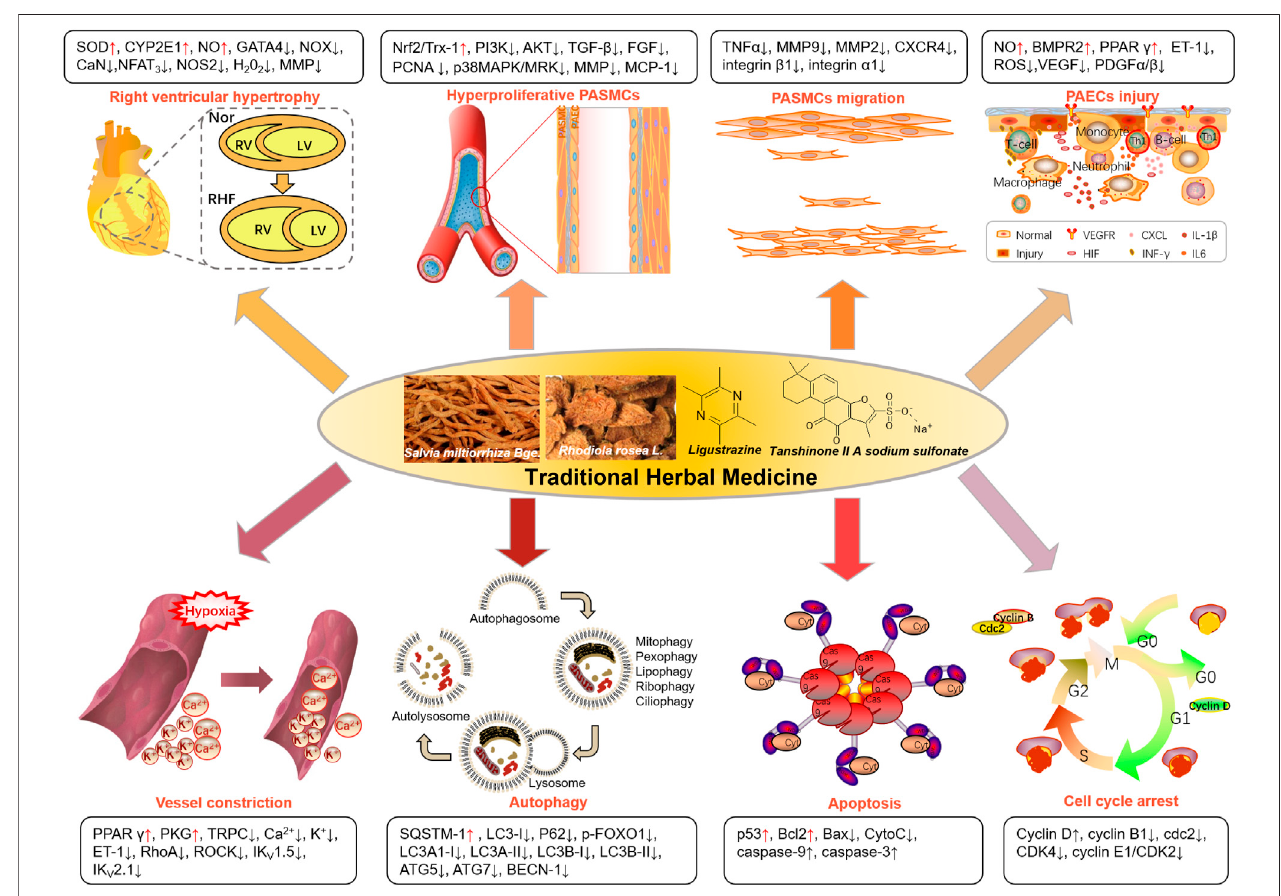
FIGURE 2 | The main biological phenomenon of THM against PAH and the relative markers